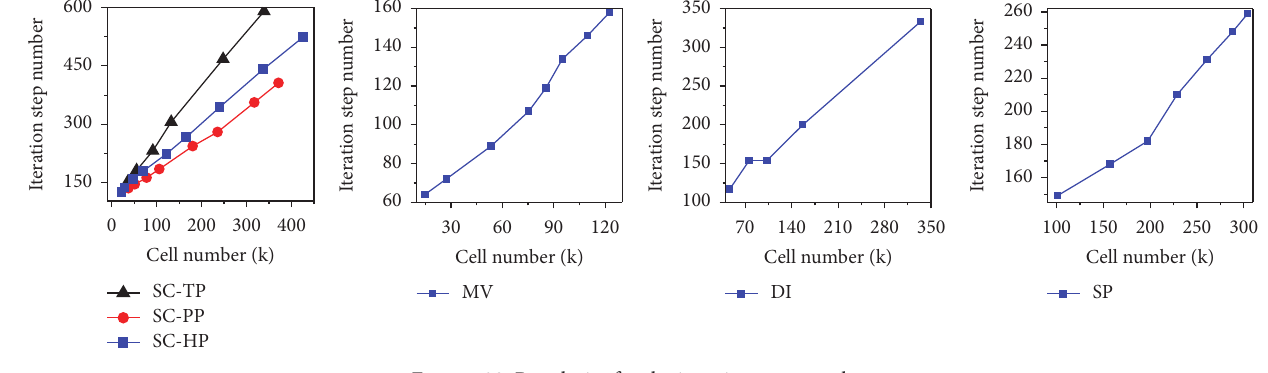
Figure 20: Regularity for the iteration step number.